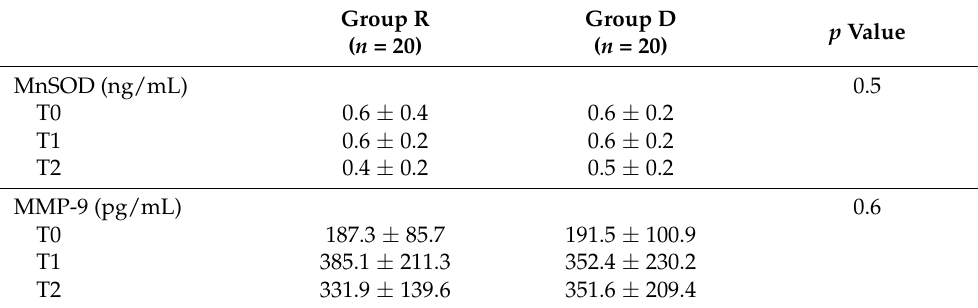
Table 4. Ancillary cytokine